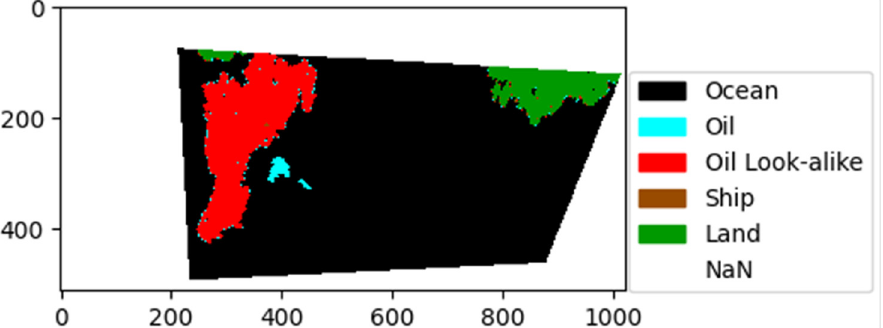
Figure 2. Incorrect labeling (Oil Spill) around edges in the outlines of the Oil Look-Alike area. Bi-linear default interpolation—mistaken label interpolation caused after